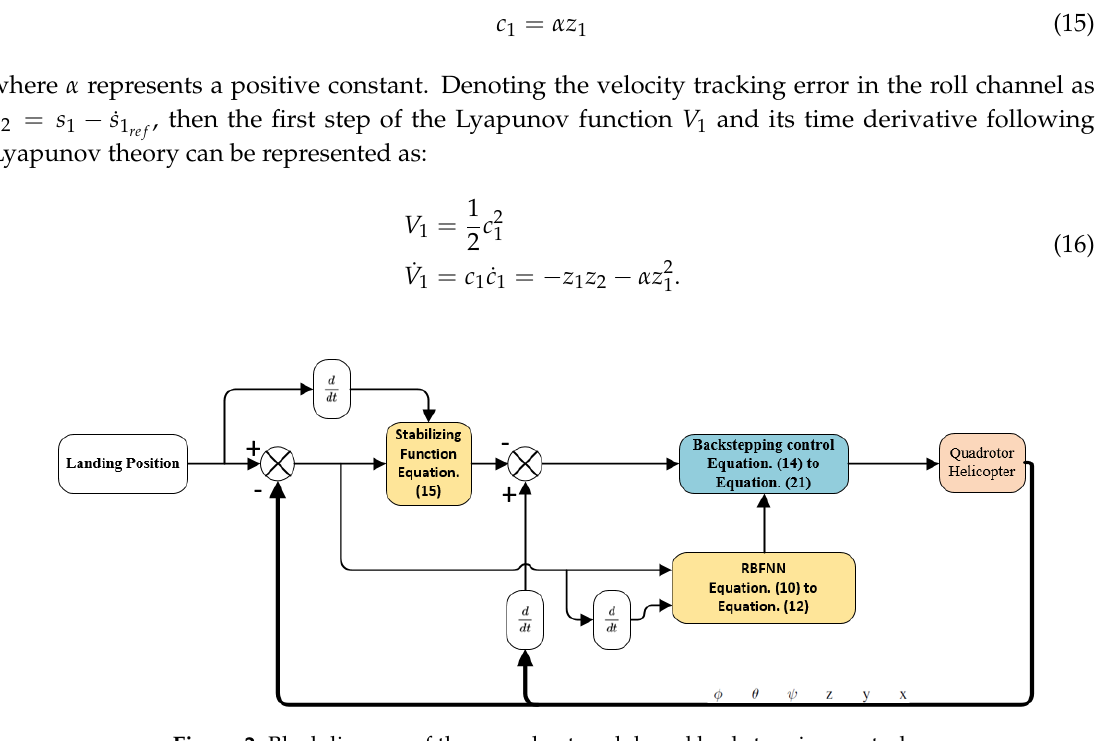
Figure 2. Blockdiagram of the neural network-based backstepping